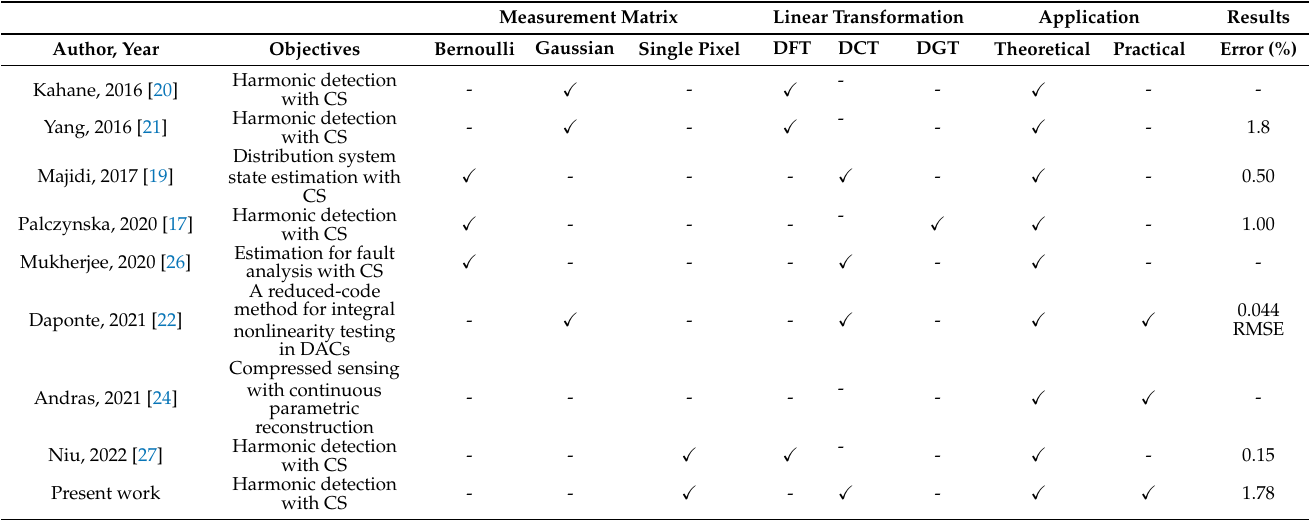
Table 2. Summary of related works and the novelty of this